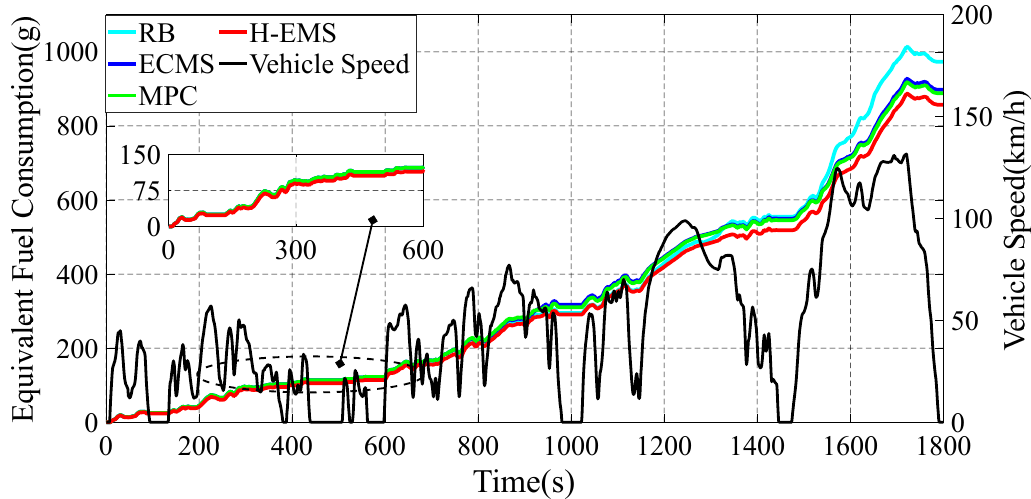
Figure 10. Variation curves of vehicle speed and equivalent fuel consumption under different strat- egies.